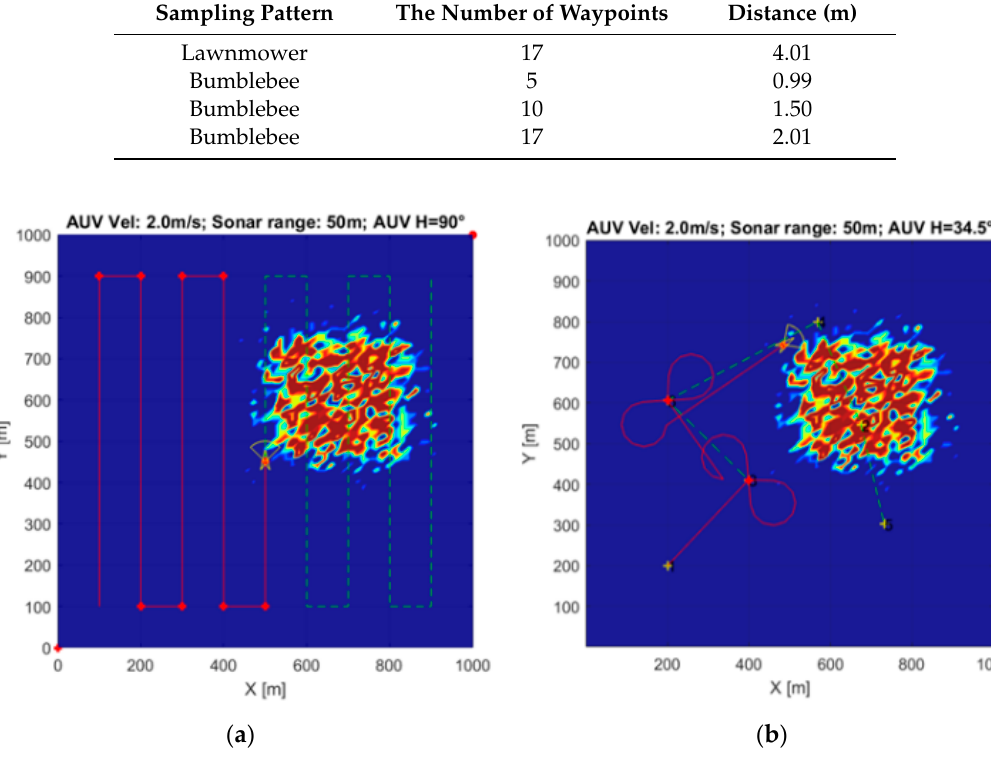
Figure 8. Simulation result using a conventional lawnmower search path with a 100 m distance interval between rectilinear legs ( a ) and an example of the bumblebee flight search path with five waypoints ( b ). Table 3. The total distance required for detection.